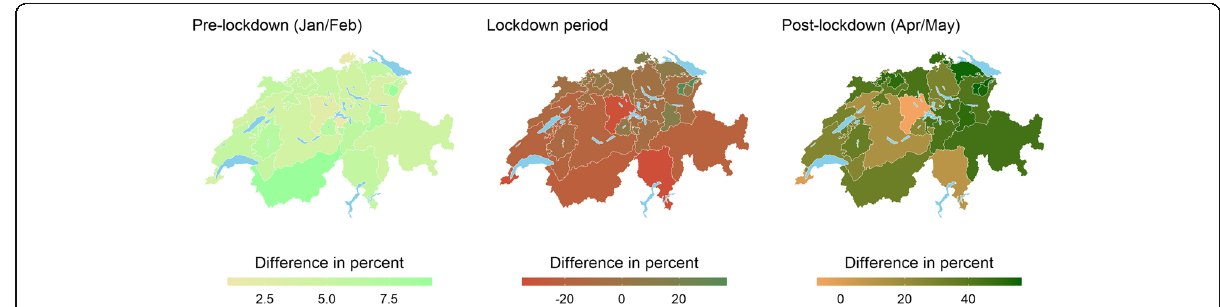
Fig. 6 Average excess retail card payments (percentages) per canton for pre-lockdown (left), lockdown (middle), and post-lockdown (right) periods. Source: Own calculations, Worldline/SPS,